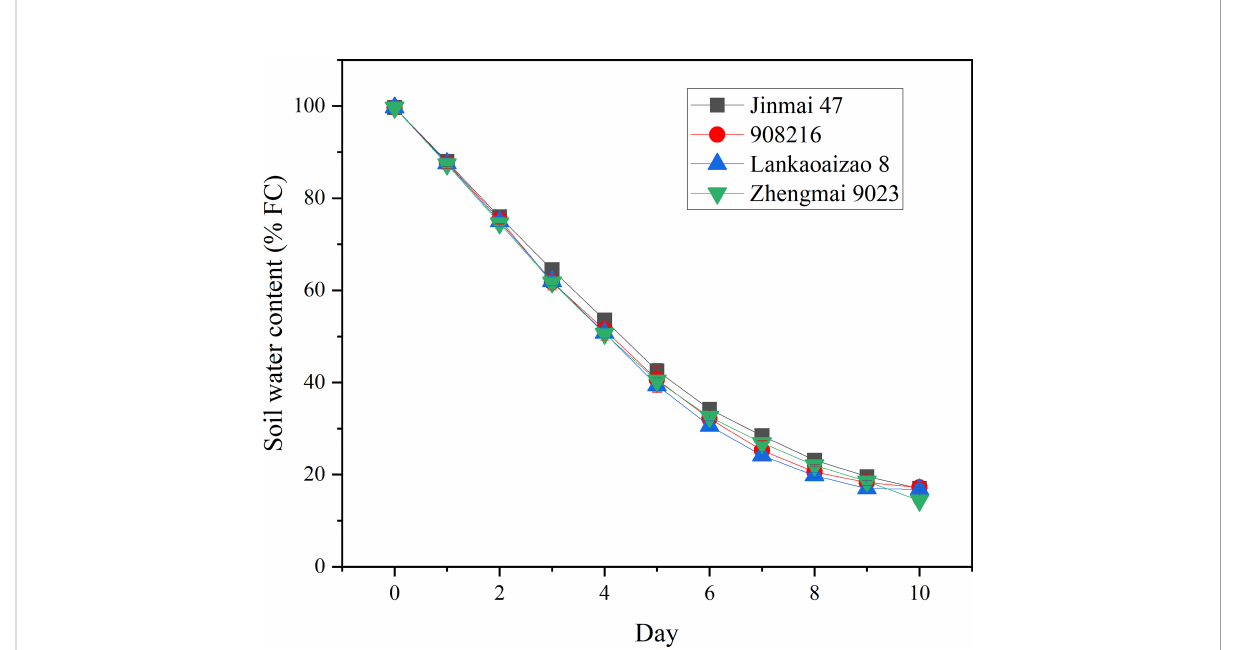
FIGURE 2 The dynamic changes in soil water content of the four genotypes exposed to progressive drought stress. The soil water content refers to the percentage of fi eld water holding capacity (FC). Values represent means ± standard errors